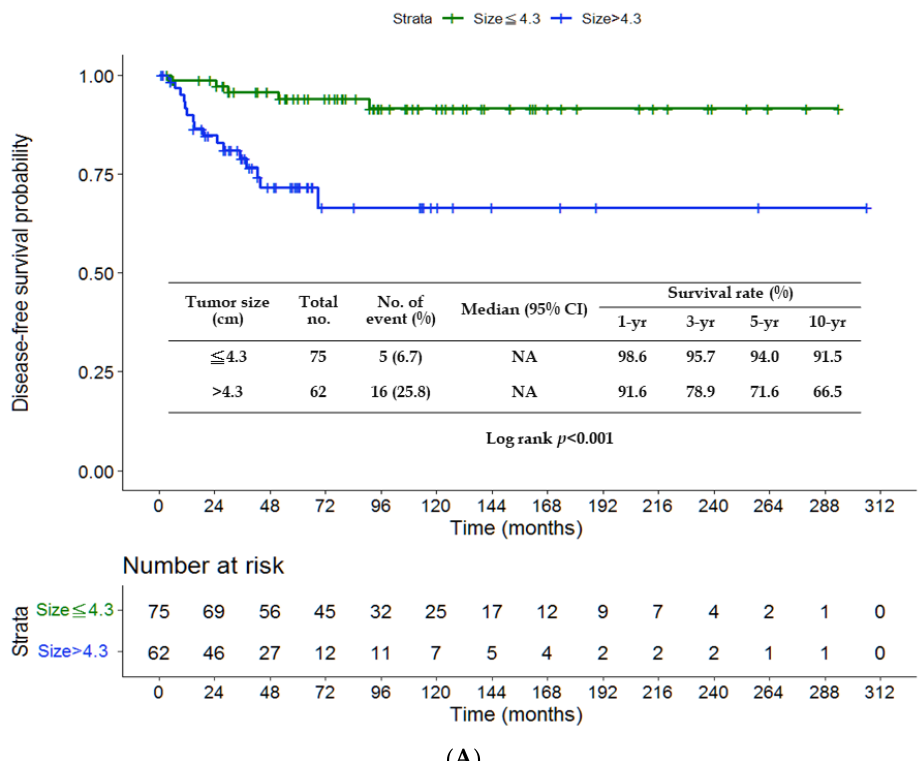
Figure 2. Kaplan–Meier curves of disease-free survival ( A ) and cancer-specific survival ( B ) in the non-chemotherapy group, and uracil-tegafur (UFT), fluorouracil or TS-1-treated group. NA, not available.